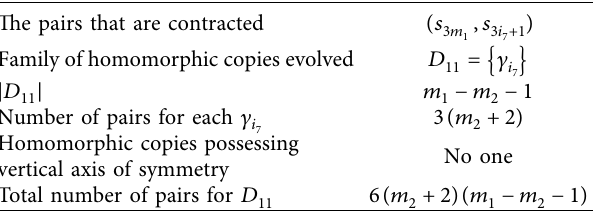
Table 10: Necessary information regarding homomorphic copies c